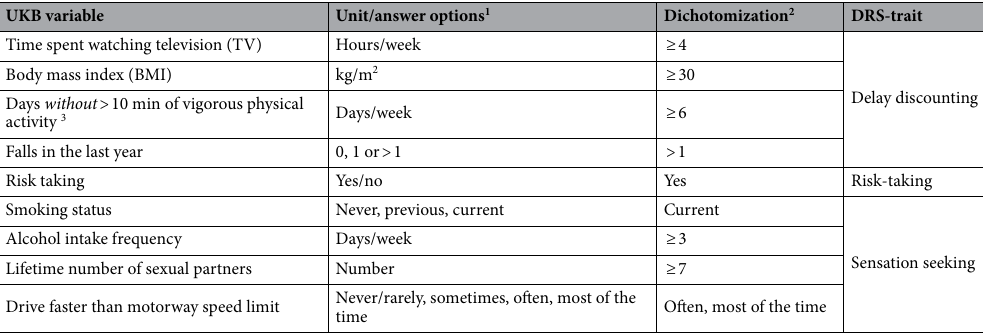
Table 2. Overview of study measures. This table shows an overview of the UKB variables used to determine the DRS-traits. The CDRS variable consists of the sum of the dichotomized versions of all these variables. 1 “Do not know” and “Prefer not to answer”, answer options were excluded from the analysis. 2 Dichotomization, indicating delay discounting, risk-taking or sensation seeking (DRS) behavior, was performed using these criteria. 3 The inverse of the actual UKB variable “Number of days/week of vigorous physical activity 10 +